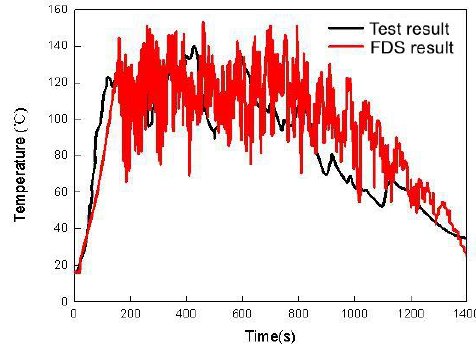
Figure 5. Comparison of temperature curves between test and FDS results.